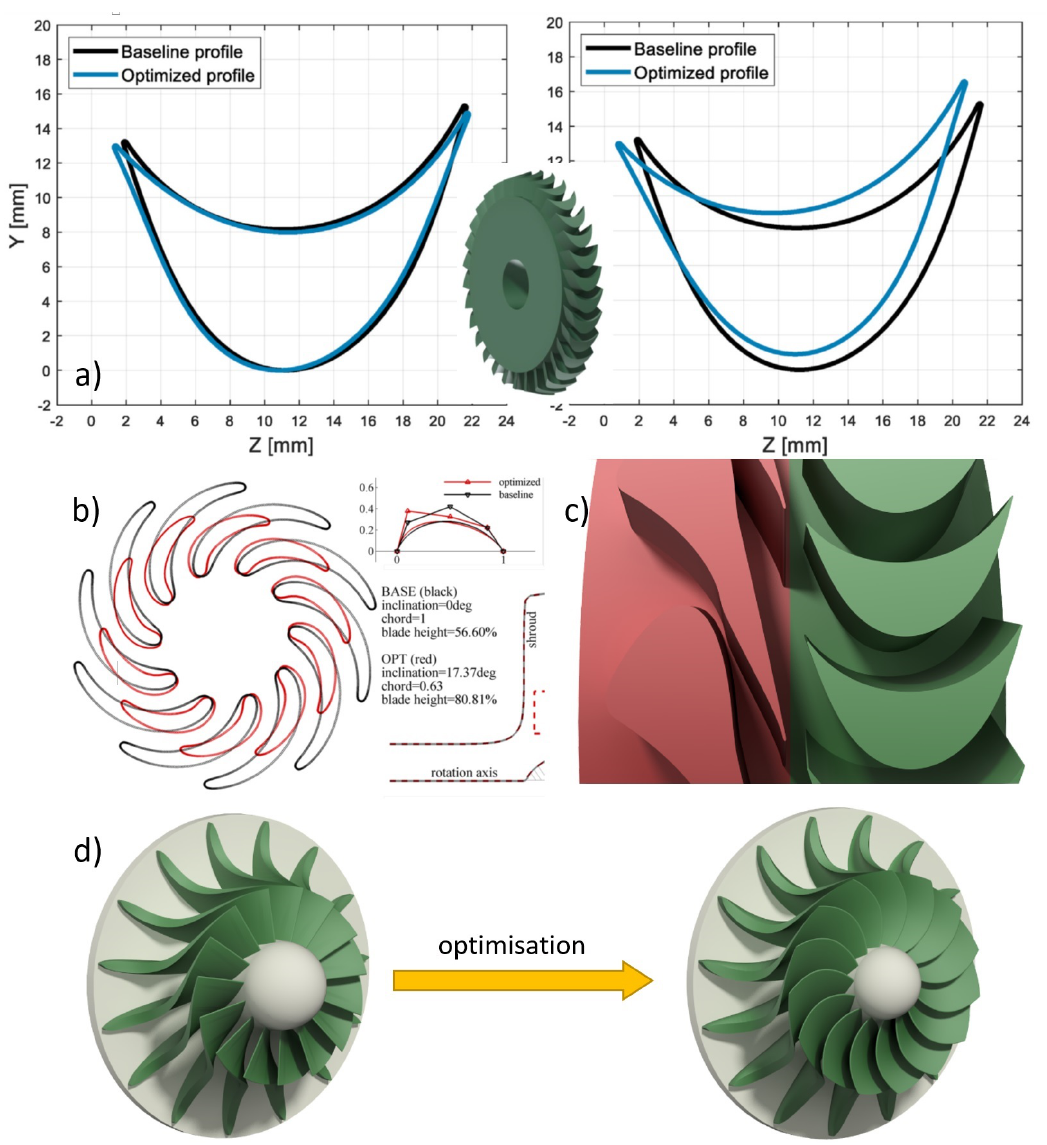
Figure 11. Examples of geometry optimisations carried out on fluid-flow machines: ( a ) optimisation of the geometry of the blades of a gas microturbine [45]; ( b ) optimisation of the rotor of an air-breathing radial outflow turbine [46]; ( c ) optimisation of the guide vanes of an ORC microturbine [47]; ( d ) optimisation of the disc of a radial-axial turbine